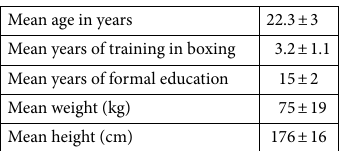
Table 1. Participants’ demographic information (n = 14), mean ± SEM (standard error of